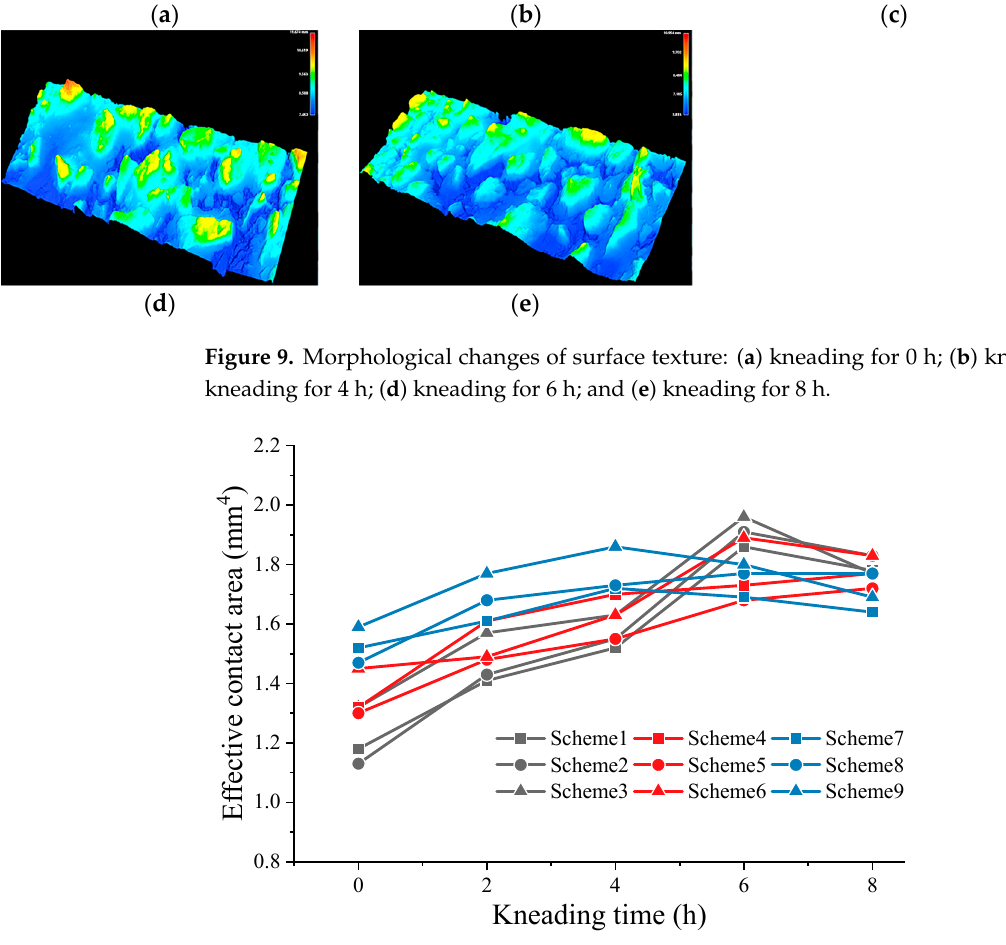
Figure 9. Morphological changes of surface texture: ( a ) kneading for 0 h; ( b ) kneading for 2 h; ( c ) kneading for 4 h; ( d ) kneading for 6 h; and ( e ) kneading for 8 h.